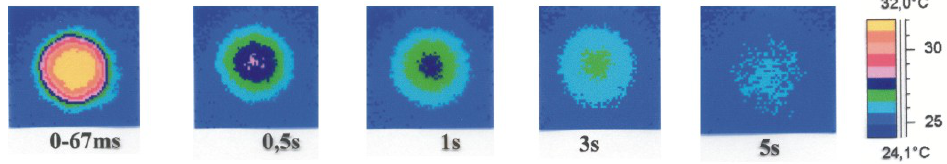
Figure 29. Rate of substrate temperature equalization (sandstone) after illumination by a laser